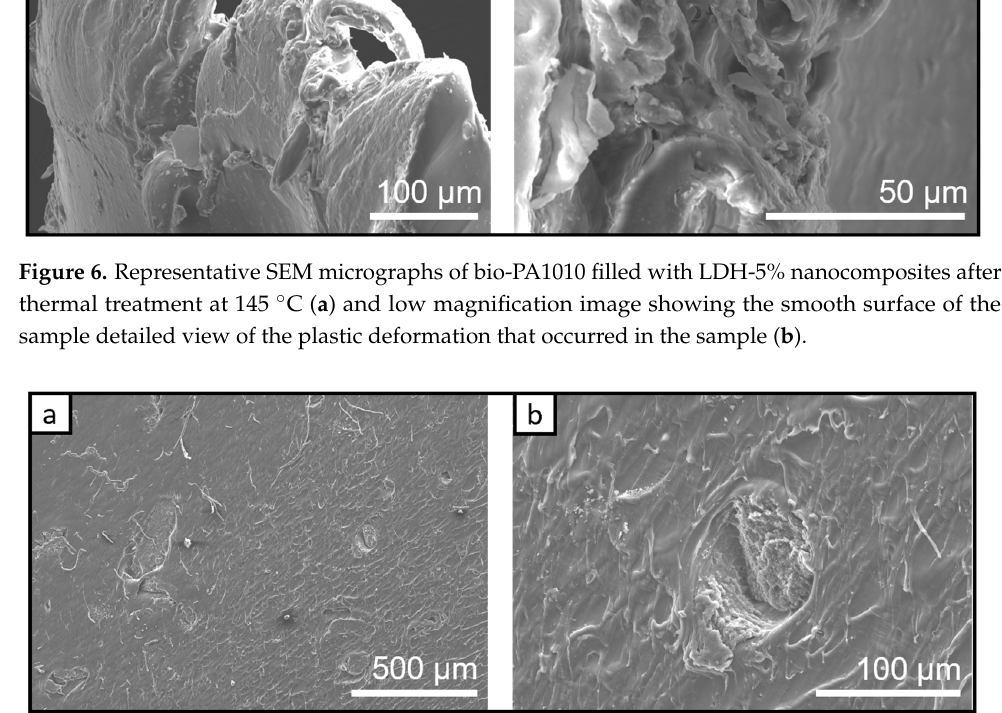
Figure 7. Representative SEM micrographs of bio-PA1010 filled with C500-4% nanocomposites after thermal treatment at 145 °C ( a , b ).